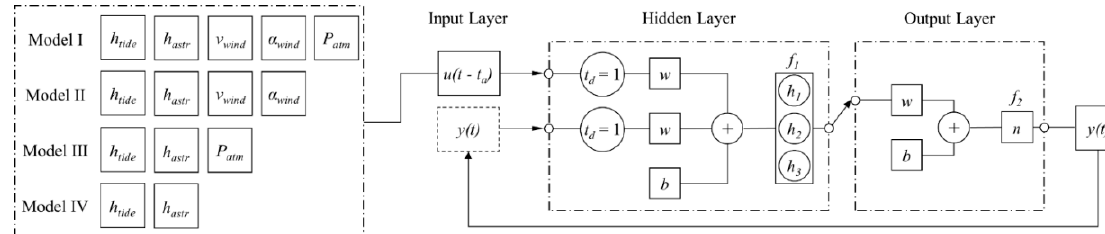
Figure 2. Sketch of the NARX model architecture.